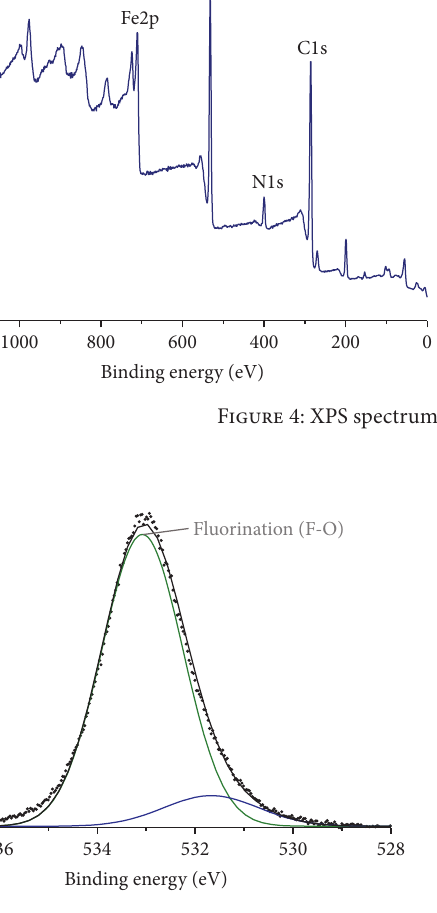
Figure 5: XPS spectrum to O1s of QE/F − . Figure 6: XPS spectrum to O1s of QEFe/F −